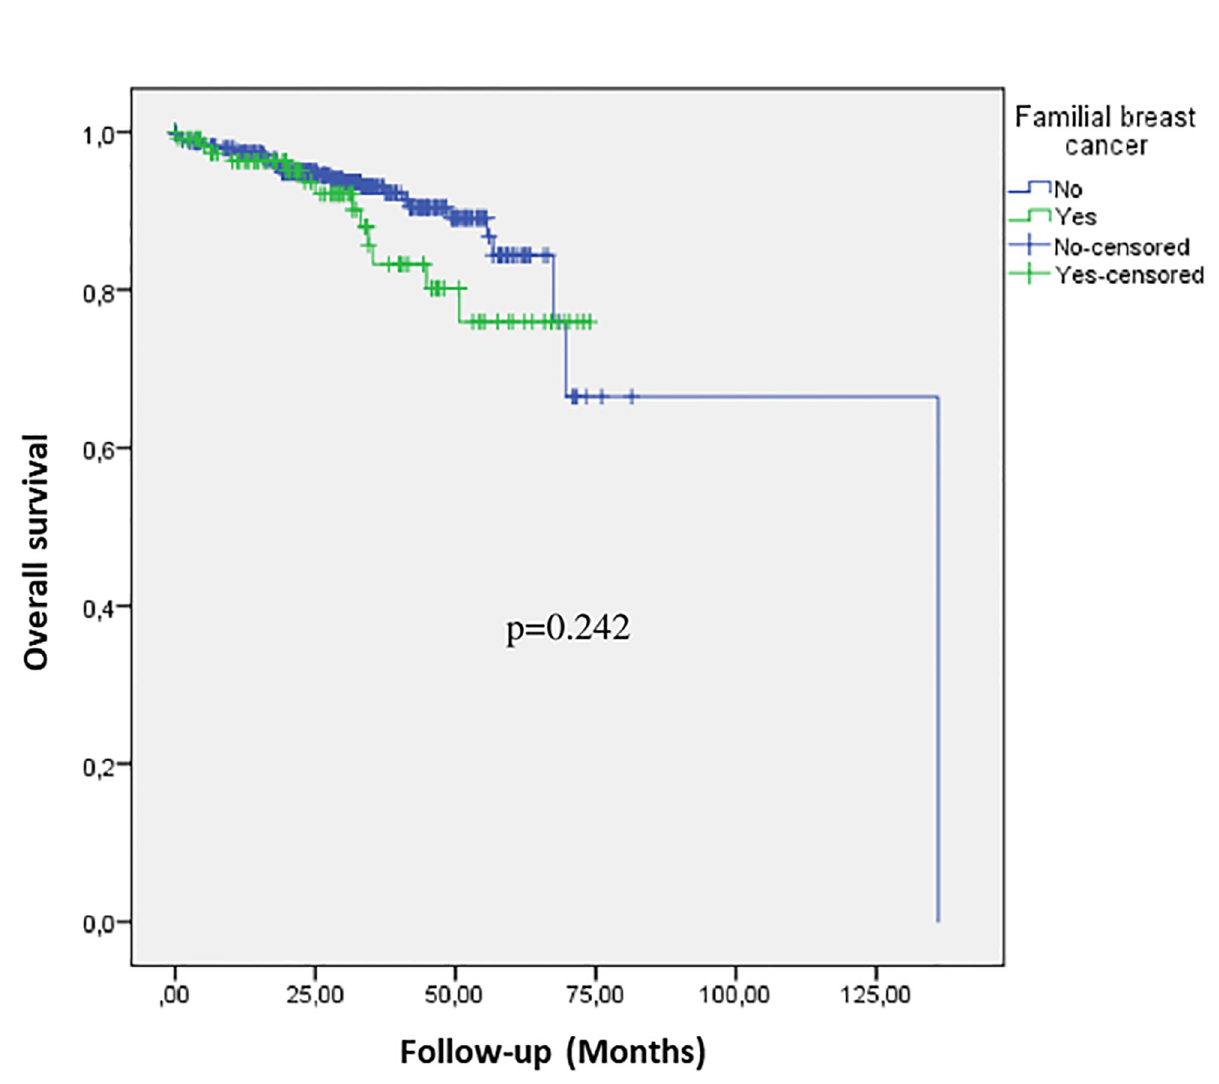
Fig 1. Kaplan Meier estimates overall survival according to familial breast cancer status. Blue line represents sporadic and green line familial